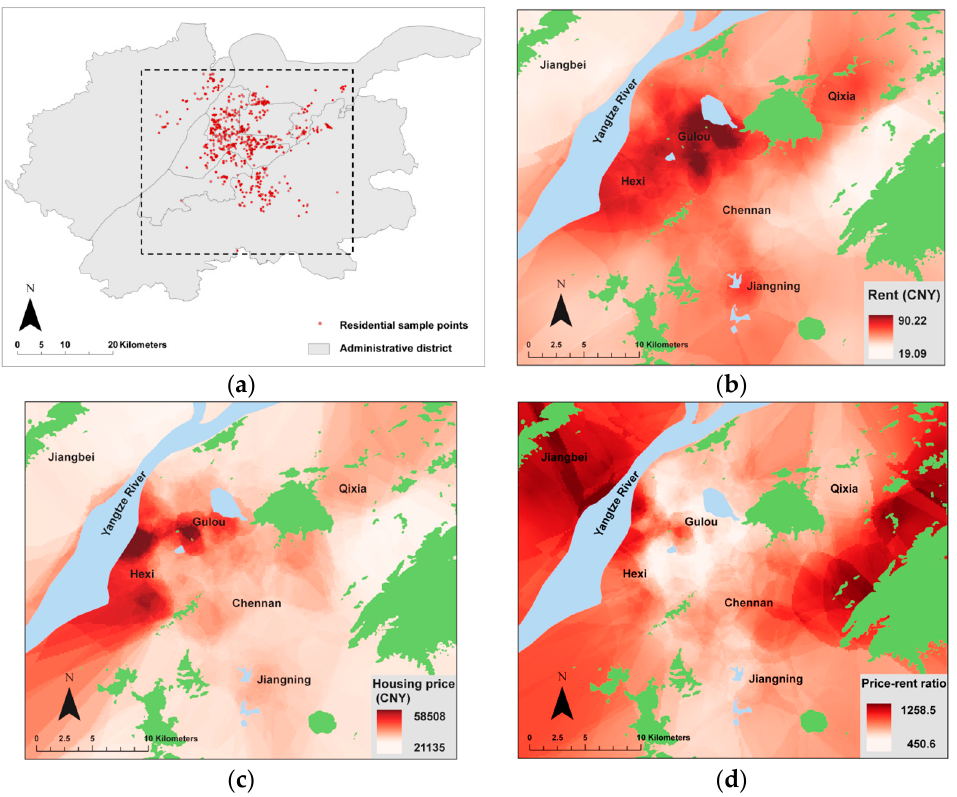
Figure 1. The spatial distribution of ( a ) sample points; ( b ) housing rent; ( c ) housing price; ( d ) the housing price–rent ratio.